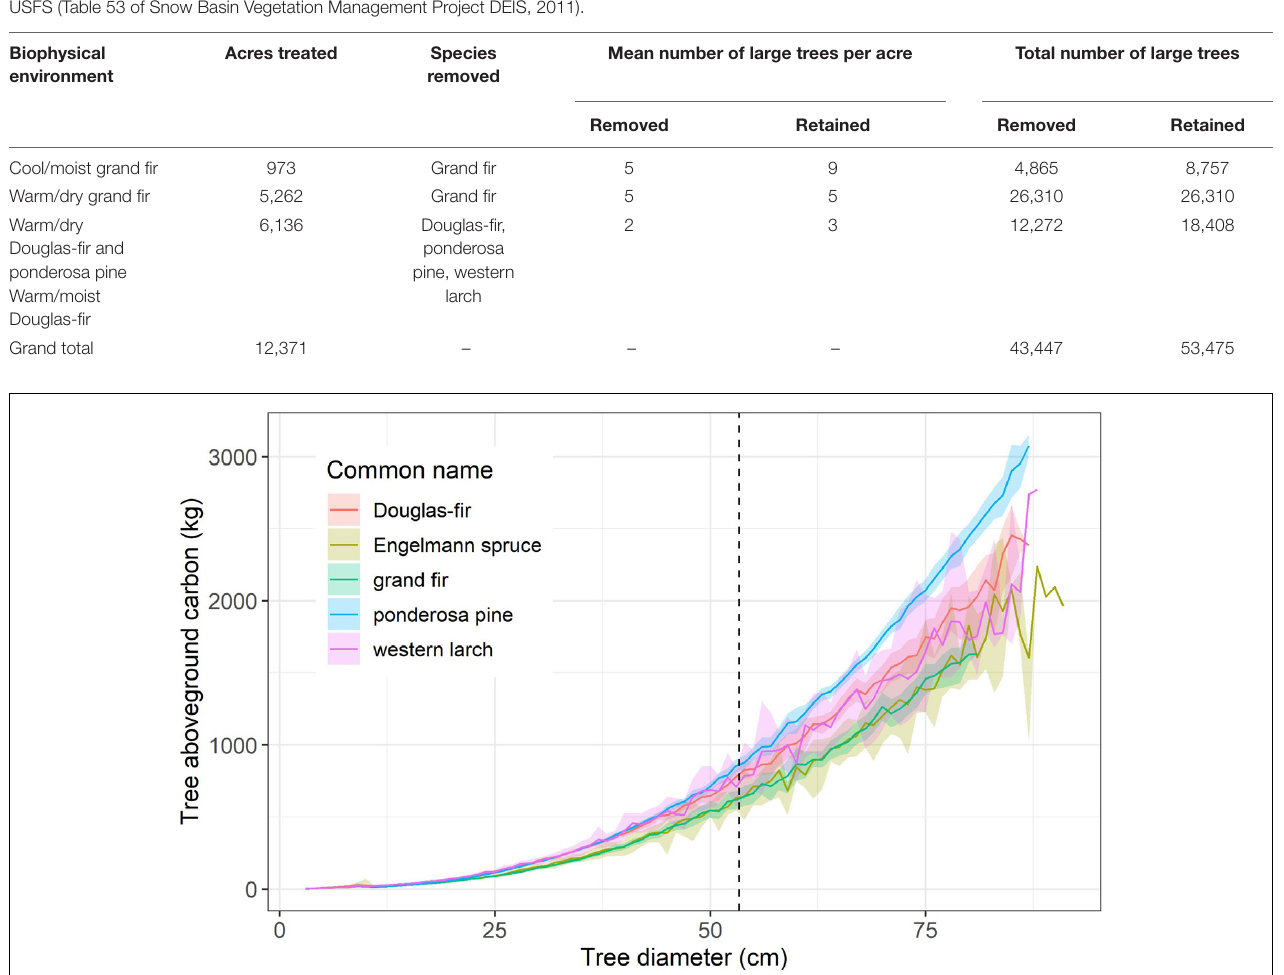
FIGURE 2 | Average tree aboveground carbon (AGC; kg) increases sharply with tree diameter at breast height (DBH; cm) for five dominant tree species measured on USFS inventory plots located in the six eastside national forests. The 21-inch (53.3 cm) DBH limit of the Eastside Screens (vertical dash line) is shown for reference. Tree AGC ( ≥ 10 cm DBH) was estimated from tree diameter and height using regional species-specific allometric equations, wood density, and carbon content. Similarly, sapling AGC (DBH = 3–9.9 cm) was estimated from sapling height using regional species-specific allometry and wood carbon content. These estimates and 95% confidence intervals were derived by resampling ( n = 10 4 ) measurements from inventory plots ( n = 3,335). For visual clarity, the tree diameter limit for each species excludes the largest 0.5% of trees, generally those larger than 80 to 88 cm